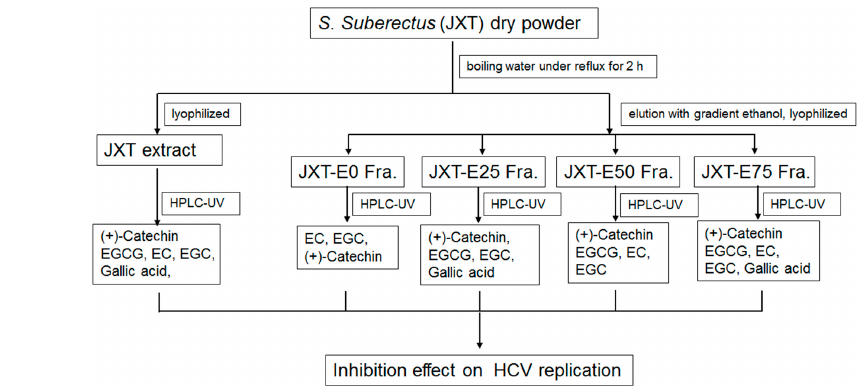
Figure 1. Extraction scheme of S. suberectus . Ethanol fractions were labeled as E followed by the percentage of ethanol used; for example, JXT-E25 means 25% ethanol eluted fraction of S. suberectus